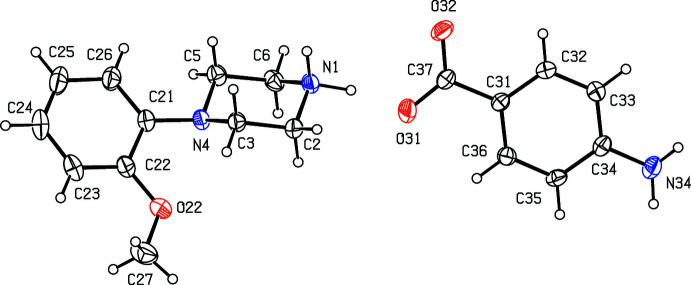
The independent components of compound (IX) showing the atom-labelling scheme. Displacement ellipsoids are drawn at the 30% probability level.